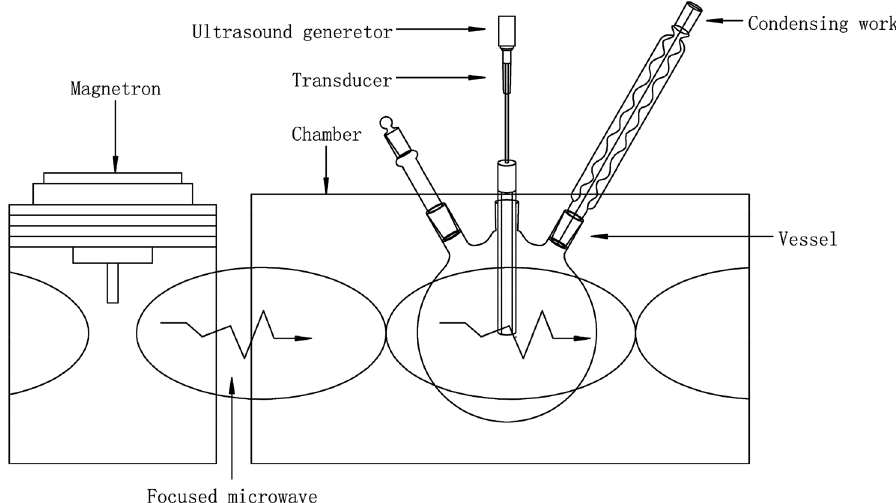
Figure 1. Schematic diagram of simultaneous ultrasound- and microwave-assisted extracting apparatus.